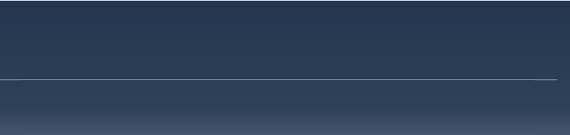
Figure 2: Rebar fi nite element model.